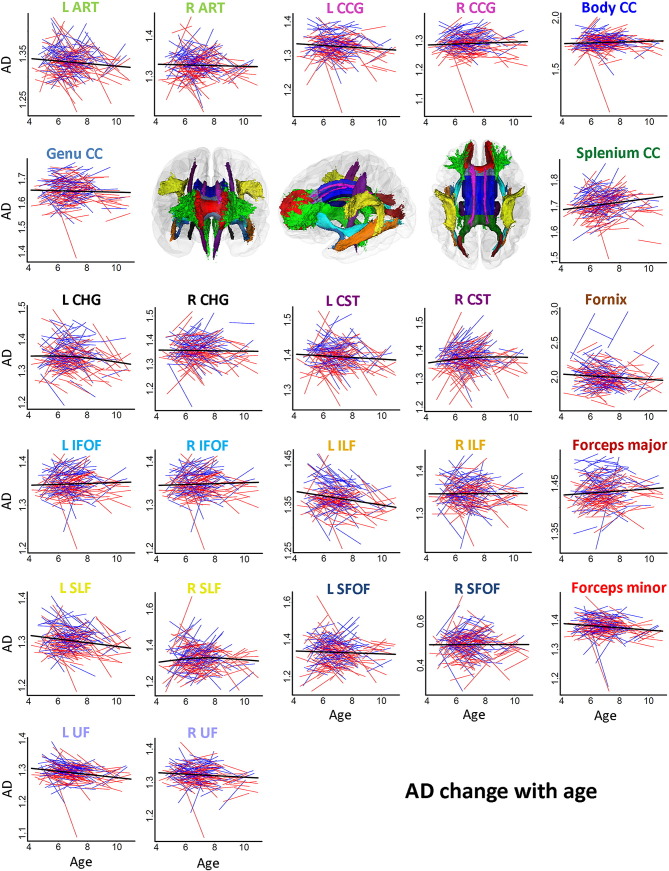
Spaghetti plots of change for AD in specific tracts with age.Spaghetti plots of individual participant change in AD in specific tracts with age (years). Females are plotted in red and males in blue. For each measure, an assumption-free general additive model as a function of age was fitted to accurately describe changes across the age range. Diffusivity values for AD are in 10− 3 x mm2/s. Diffusivity values for AD are 10− 3 x mm2/s. Three-dimensional renderings of the probabilistic tracts illustrate fifteen atlas-based probabilistic tracts from the Mori atlas as for Fig. 3.